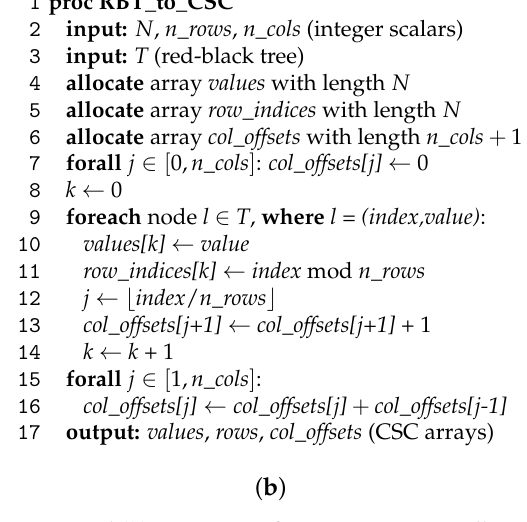
Figure 5. Algorithms for: ( a ) conversion from CSC to RBT and ( b ) conversion from RBT to CSC. All arrays and matrix locations use zero-based indexing. N indicates the number of non-zero elements, while n_rows and n_cols indicate the number of rows and columns, respectively. Details for the CSC arrays are given in Section